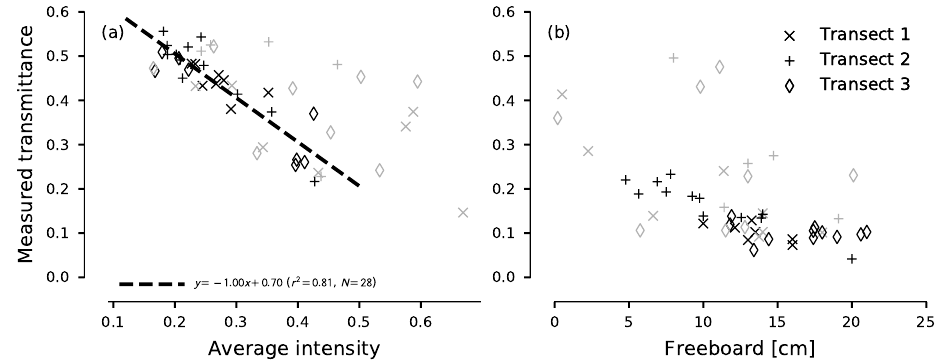
Figure 3. (a) Measured bulk transmittance under ponds versus surface average intensity determined from an aerial photo (see Fig. 4). The dashed line is a regression lines for only locations away from pond edges (black markers). (b) Measured bulk transmittance versus measured freeboard. For both panels, the light grey markers are for locations close to the boundary between ponds and bare ice.